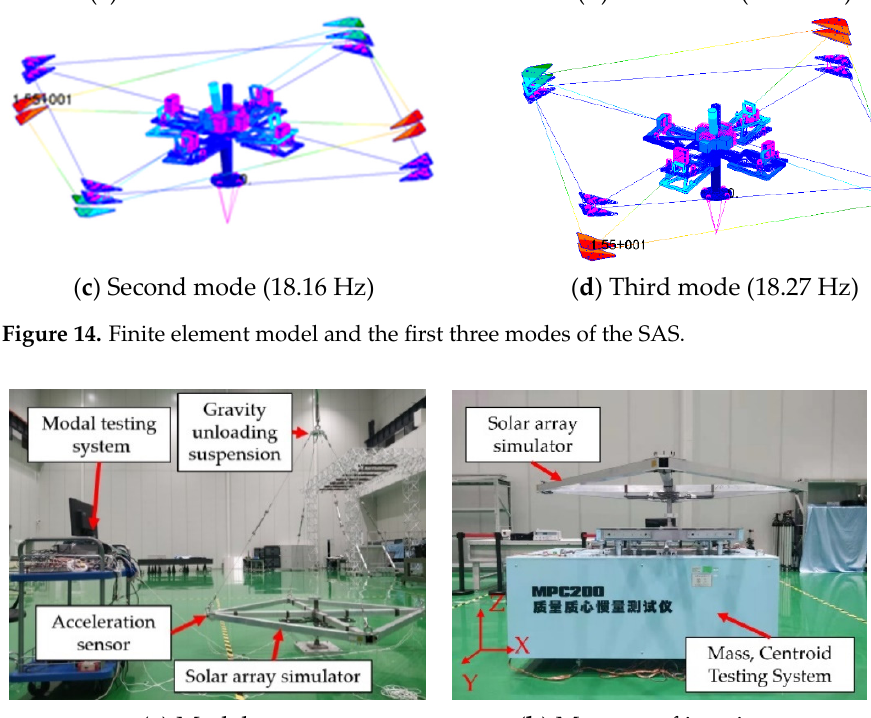
model was 0.27 kg · m 2 , and the relative error was only 3.3%. Table 4 shows the frequencies